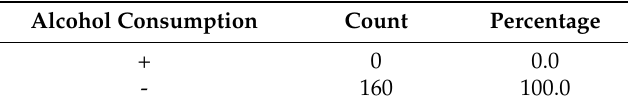
Table 2. Alcohol consumption among the study group ( n = 160).